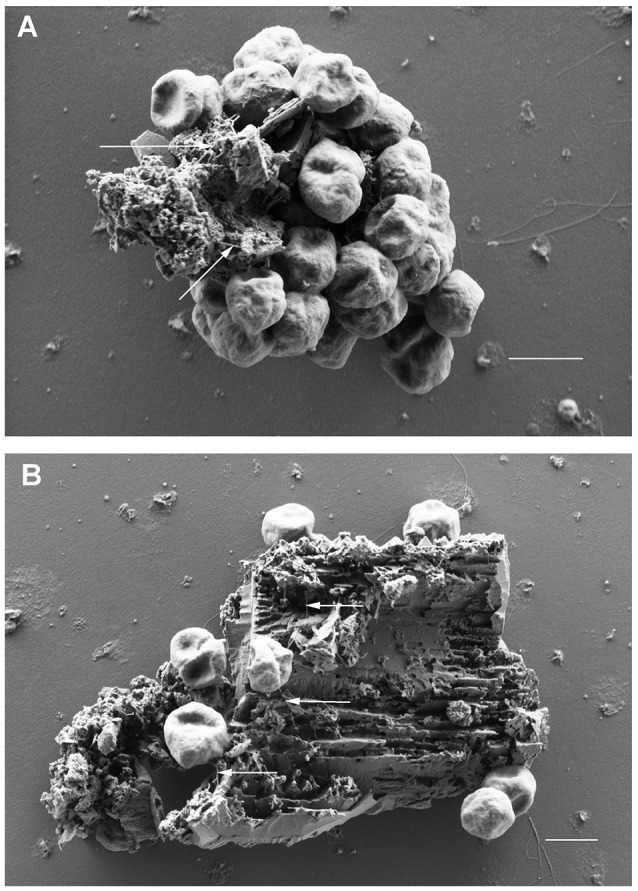
Scanning electron microscopic analyses of P. furiosus Vc1 cells adhering to BSM solids. (A) BSM solids of the grainy, amorphous type; (B) BSM solids of the unstructured type. Arrows in panels (A,B) highlight flagella. Size bars in (A,B) 1 μm.